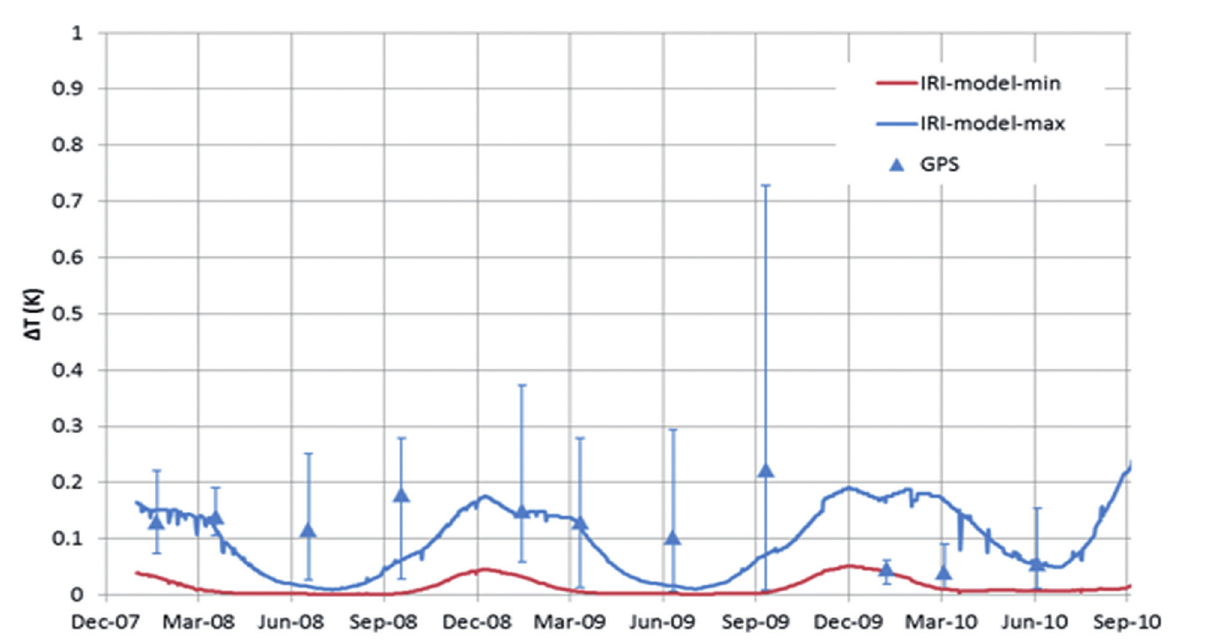
Figure 10. D T variations over direction 4 computed using the sTEC data derived from the GPS data (triangles) or the IRI model (red, blue